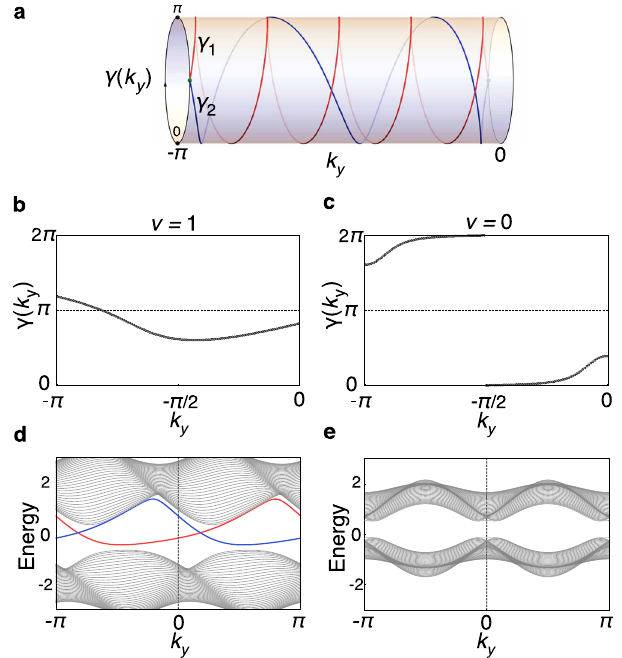
Fig. 4 Topological invariant and edge states. a Schematic illustration of the formula in Eq. (9). The red and blue paths correspond to the topologically nontrivial and trivial cases, respectively. b and c depict the fl ows of γ ( k y ) for two set of parameters for the model in Fig. 2a, and the corresponding band structures on a ribbon geometry with edges along y are given in d and e , respectively. States on right/left edge are marked in red/ blue